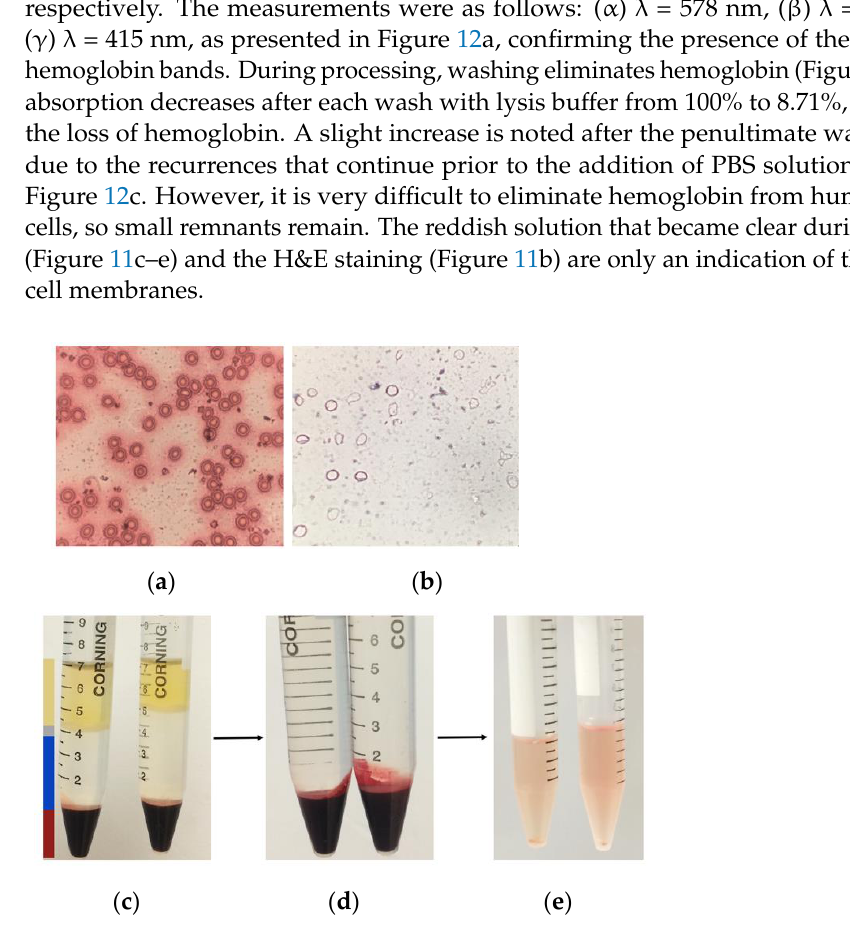
Figure 11. ( a ) Optical microscope images of red cells, ( b ) erythrocyte ghosts, ( c ) separation of blood components; yellow is serum, gray is lymphocytes, and red is erythrocytes. ( d ) Isolated erythrocytes and ( e ) erythrocyte ghost membranes.